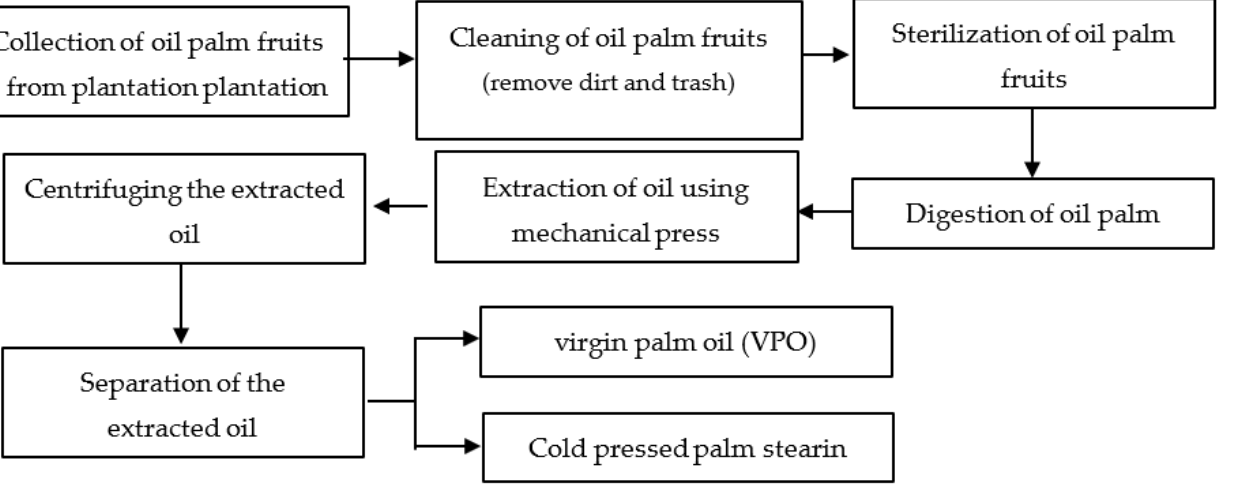
Figure 1. Process for the production of virgin palm oil using the cold-press extraction method .